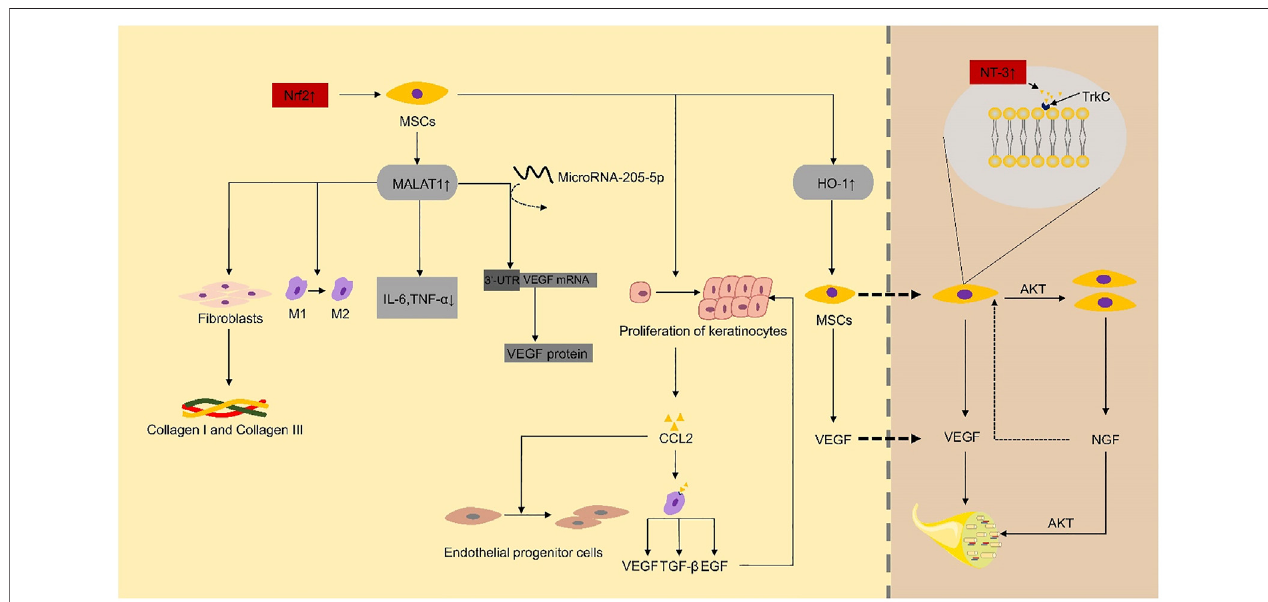
FIGURE2| Nrf2andNT-3playacriticalroleaskeyfactorsintherepairofdiabeticfootulcersbymesenchymalstemcells.IL-6,interleukin-6;TNF- α ,tumornecrosis factor- α ; TGF- β , transforming growth factor- β ; EGF, epidermal growth factor; VEGF, vascular endothelial growth factor; MSCs, mesenchymal stem cells; NGF, nerve growth factor; Trk, tropomyosin receptor